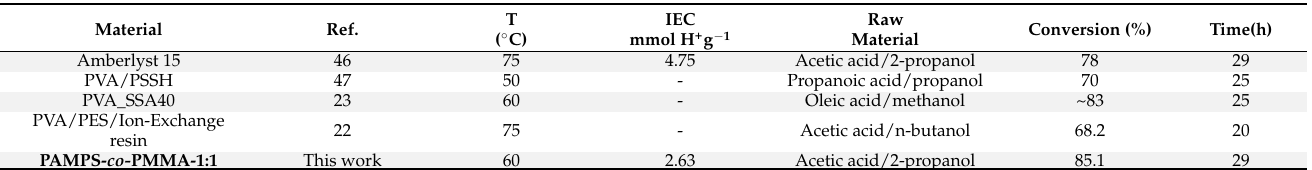
Figure 6. Isopropyl acetate conversion versus reaction time for PAMPS- b -PMMA-1:1 ( (cid:78) ), PAMPS- co - PMMA-1:1 ( • ), and without catalyst ( (cid:4) ), at 60 ◦ C for 29 h. Table 2. Esterification performance by Amberlyst and PVA-based acid catalytic membranes, in comparison with the PAMPS- co -PMMA-1:1 membrane reported in this